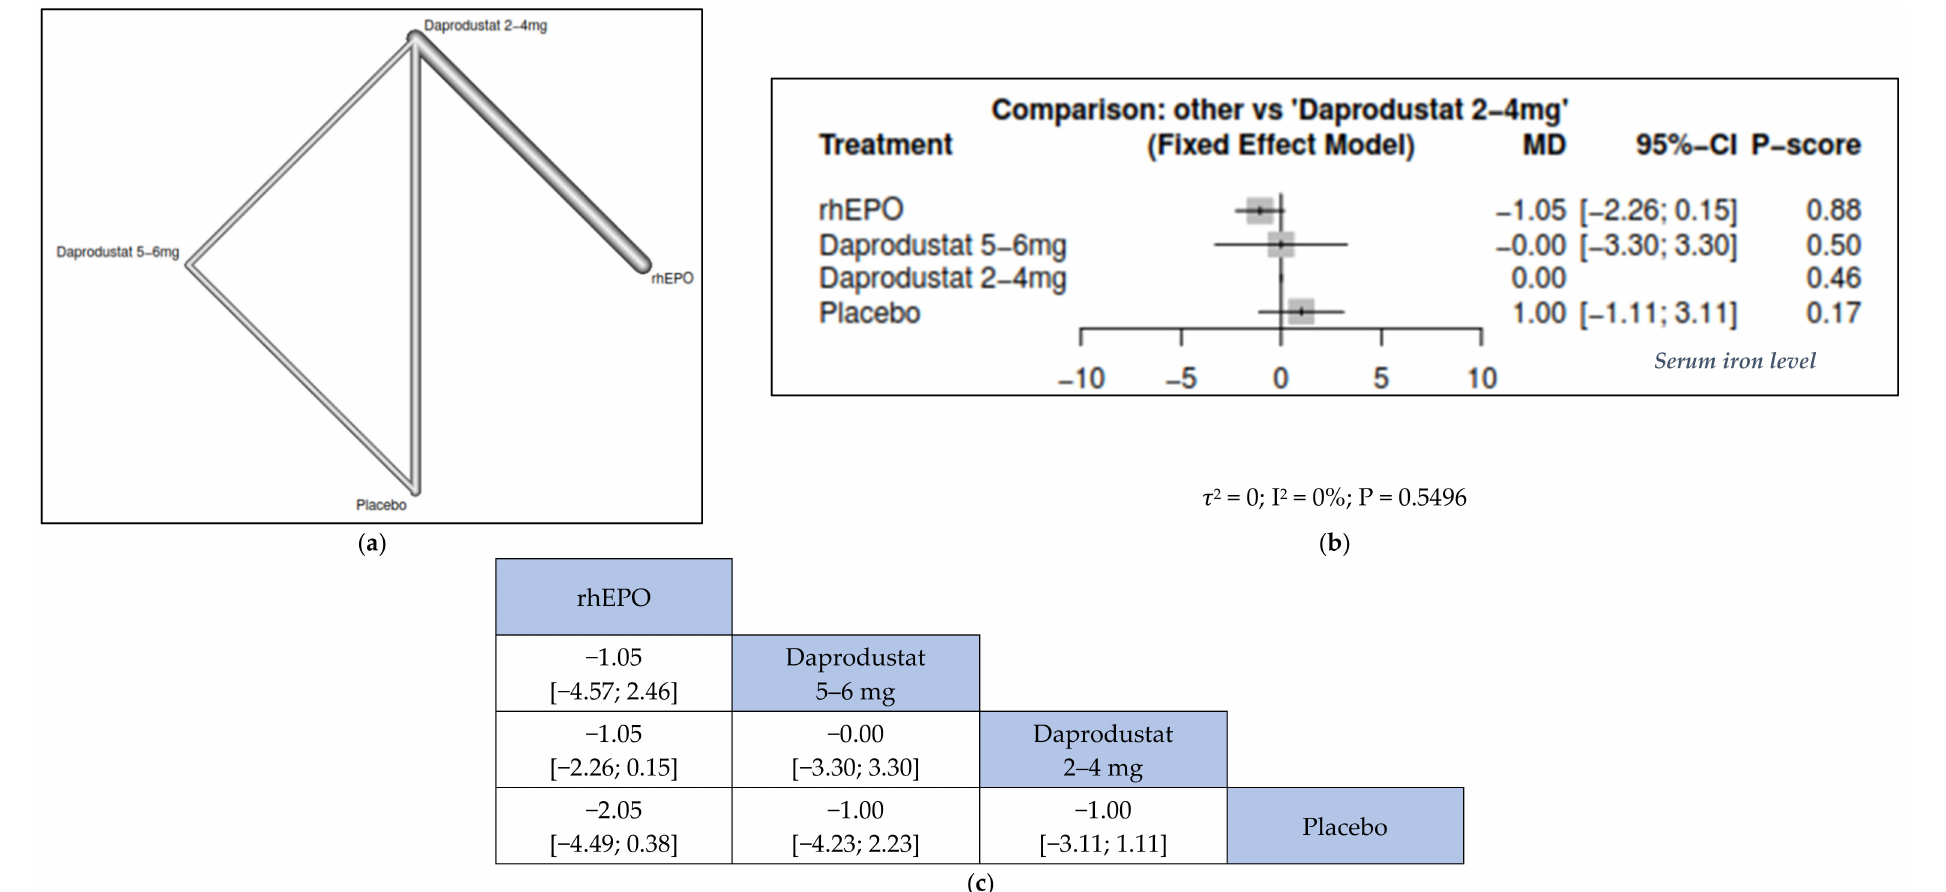
Figure 6. Network meta-analysis results of serum iron. ( a ) Network graph showing direct evidence between the assessed interventions. ( b ) A forest plot was generated by comparing all interventions with “placebo”; P-score was used for ranking. ( c ) The league table represents the network meta-analysis estimates for all interventions comparisons; the results are the mean difference (MD) with 95% CI, bold items are statistically